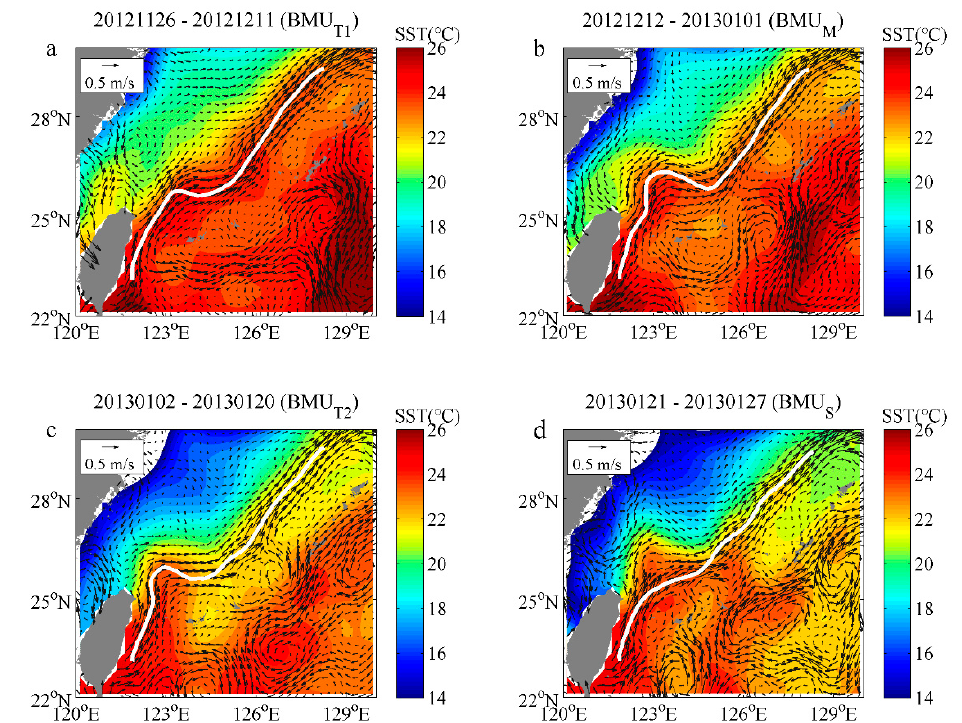
Figure 14. Same as Figure 13, but for AVHRR multi-day mean SST.